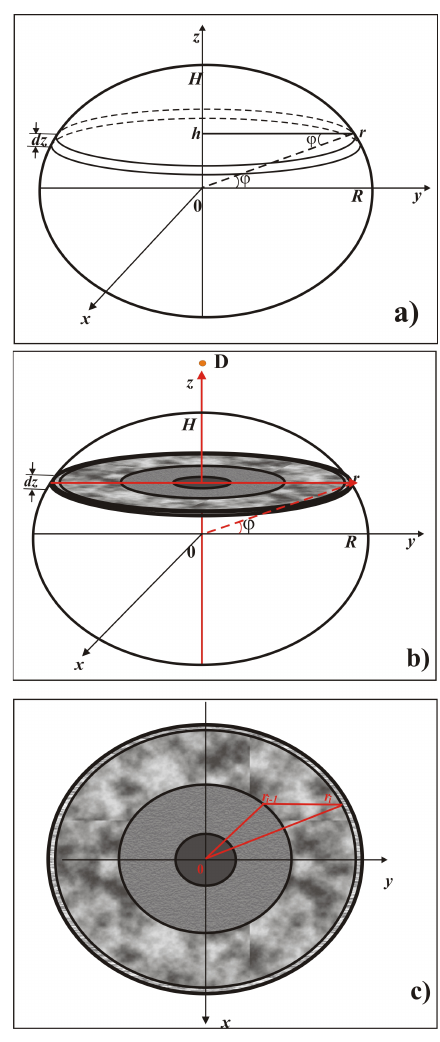
Fig. 2. The sketch of the HomED model (a) , the sketch of the HetED model (b) , and the vertical view on the disk plane shown on (b) from point D (c) . Here R is the equatorial Earth radius and H is the polar radius, ϕ is the latitude of a given infinitely thin disk, h is the distance between the Earth’s center and the disk plane, and r i − 1 and r i are outer radiuses of the two consecutive rings. The displayed rings do not identify with any determined geospheres of the Earth. This sketch is only an illustration of the calculation method of the moment of inertia for every